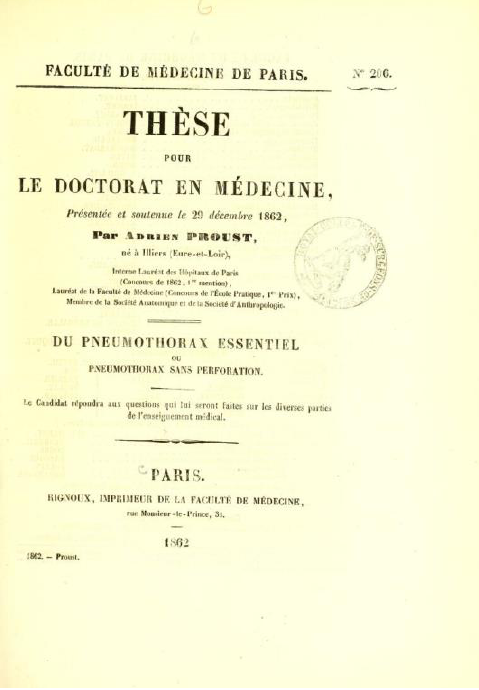
Figure 2. Frontispiece of Proust’s 1862 medical doctoral dissertation Du pneumothorax essentiel ou pneumothorax sans perforation . The text is freely accessible on the Wellcome Collection’s website: https://wellcomecollection.org/works/nybrbuus (last accessed on 27 February 2022).